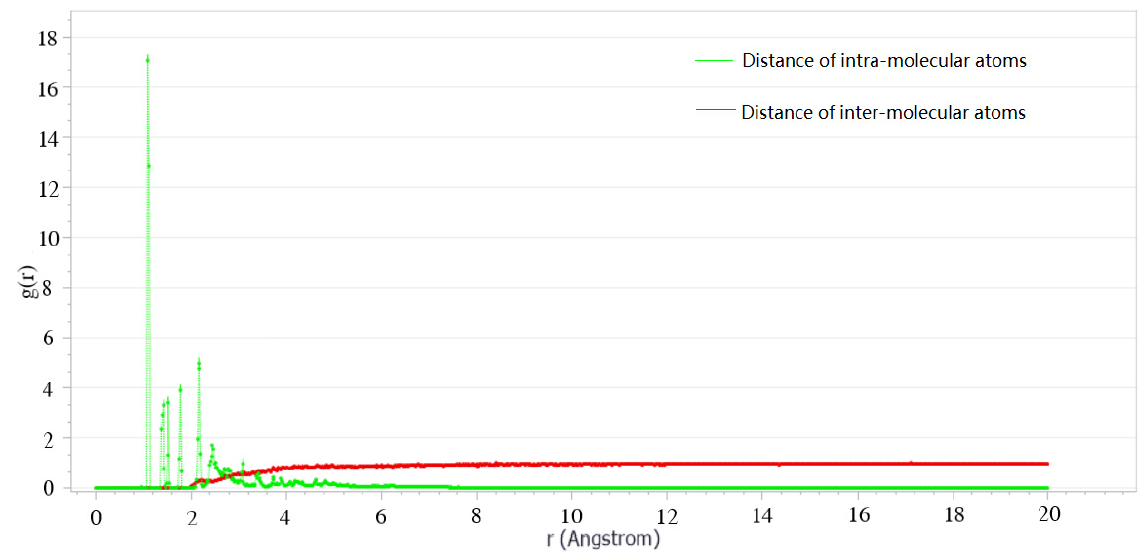
Figure 4. Radial distribution function (RDF) for distances of intra-molecular and inter-molecular atoms in asphalt molecular models.